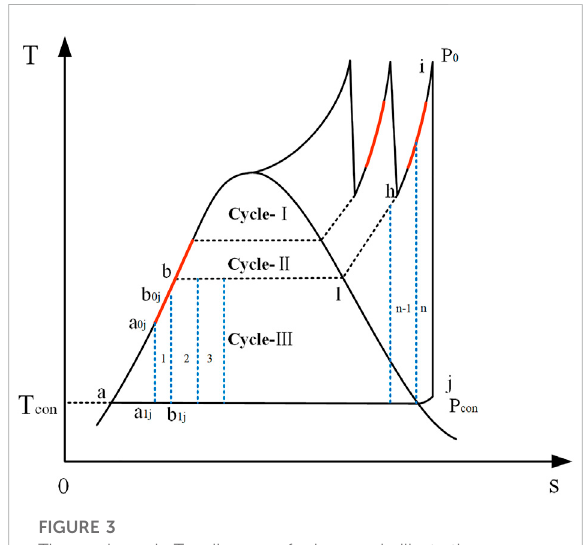
FIGURE 2 Thermodynamic T-s diagram of the double-reheat Rankine cycle.